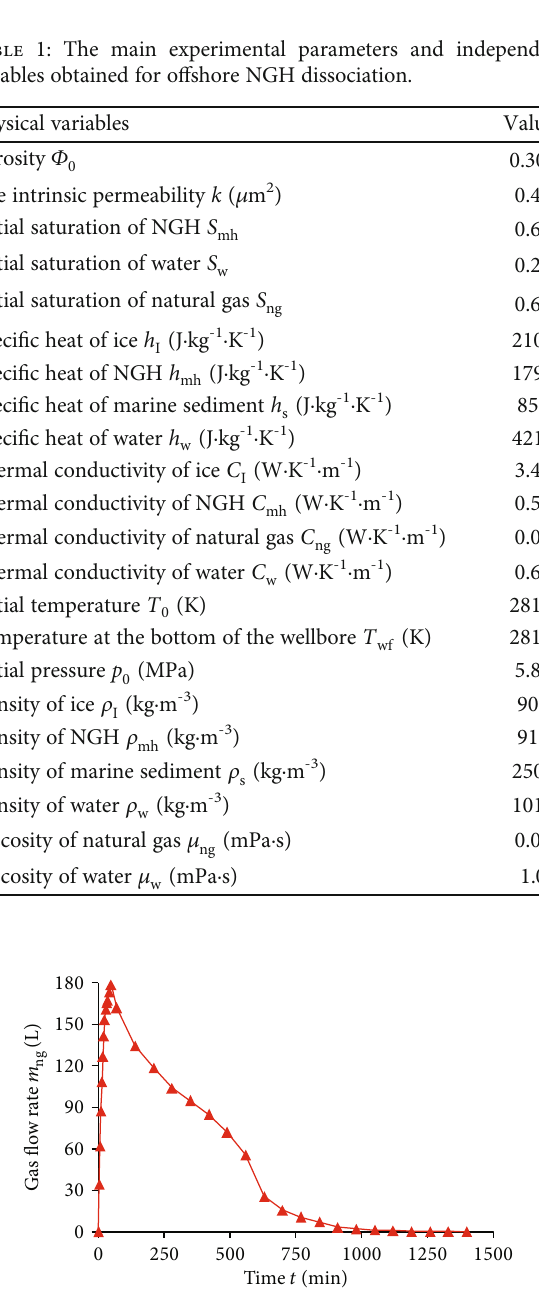
Figure 2: The variation of natural gas fl ow rate with time in 3-D marine sediments for the whole o ff shore natural gas production process.